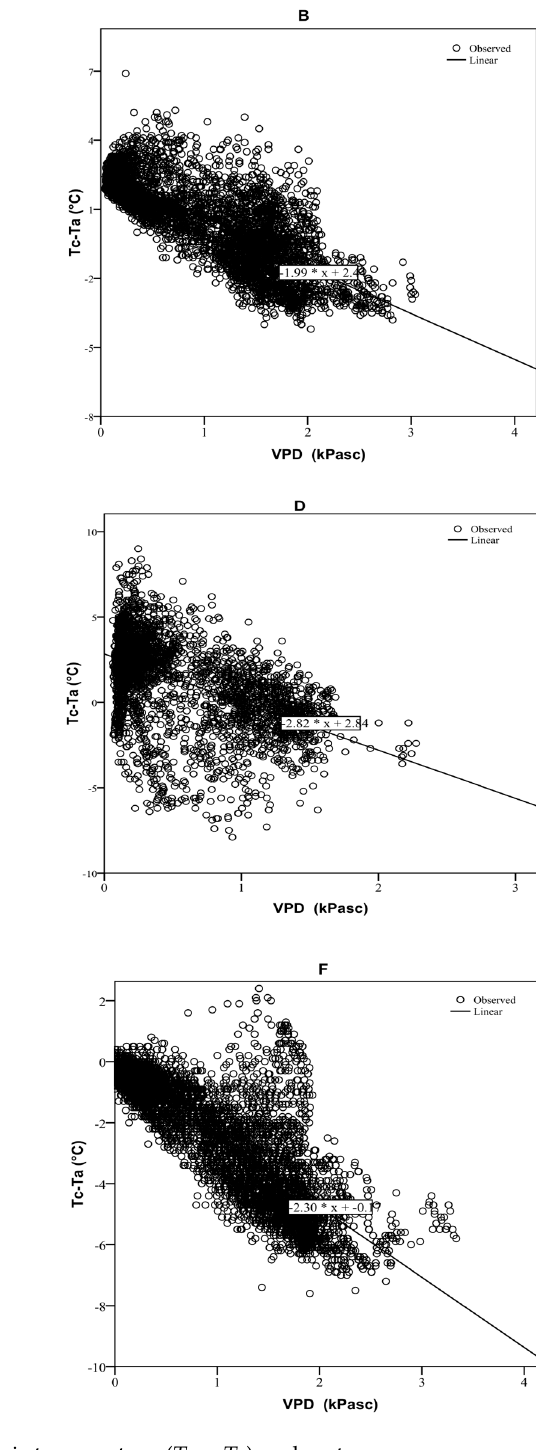
Figure 2. Relationship between canopy minus air temperature ( T c − T a ) and water vapor pressure deficit (VPD); ( A , B ), first experimental period (March to June); ( C , D ), second experimental period (October to December); ( E , F ), third experimental period (March to June); ( A , C ), greenhouse span with a forced air ventilation system; ( E ), greenhouse span with a forced air ventilation system and whitewash; ( B , D , F ), greenhouse span with a fan and pad evaporative cooling system combined with natural and a forced air ventilation system.